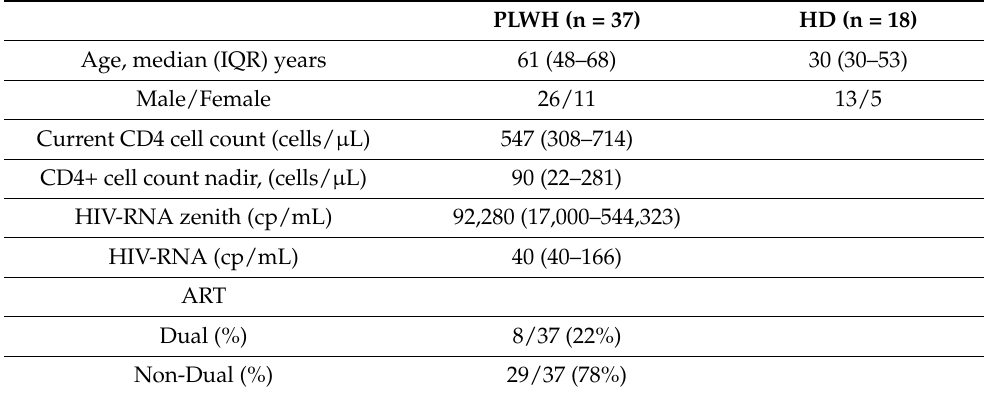
Table 1. Demographic and clinical characteristics of the study